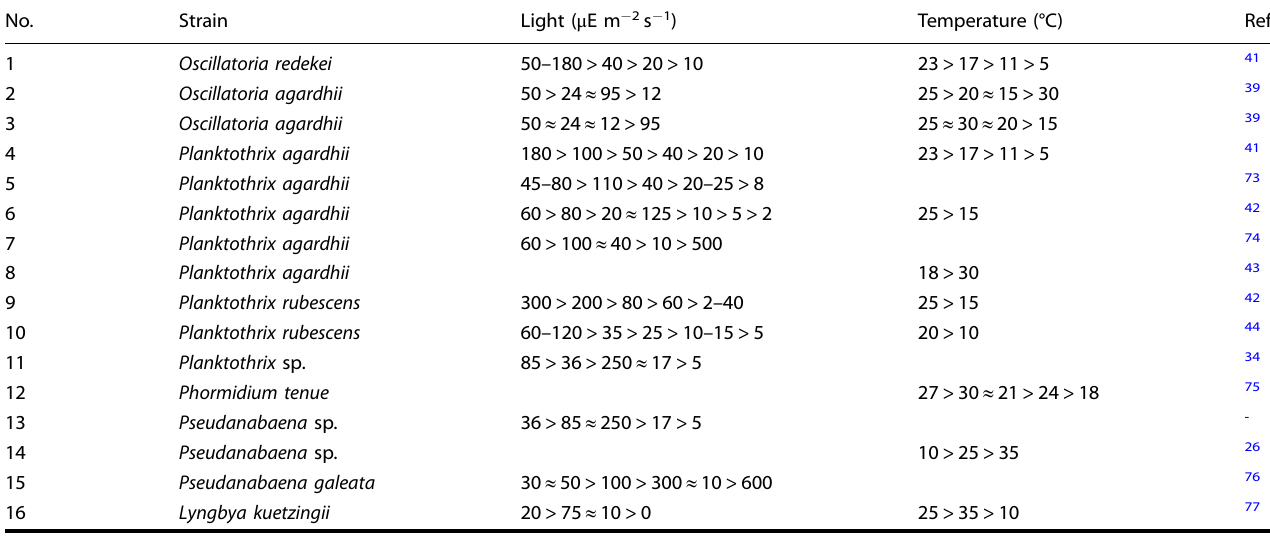
Table 1. Effects of environmental factors on fi lamentous cyanobacterial